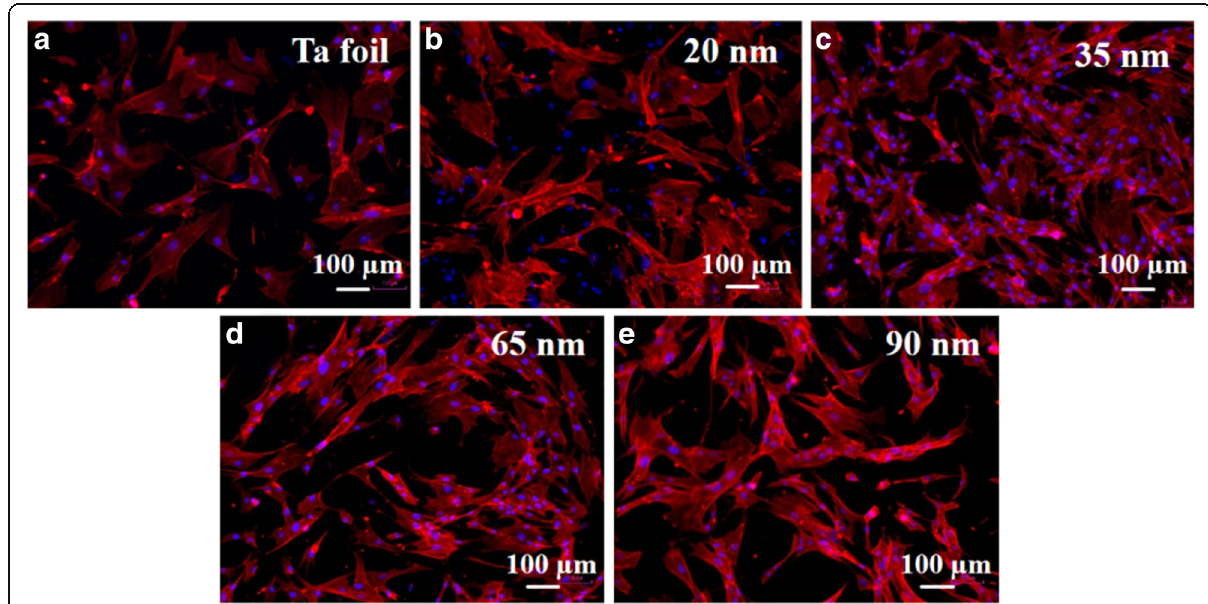
Fig. 6 Fluorescence microscopy images of the fibroblast cell attachment on the a Ta foil and self-organized TaO x nanotubes with diameters of b 20, c 35, d 65, and e 90 nm, respectively. The red fluorescence indicates cytoskeletal protein actin filament, and the blue fluorescence indicates